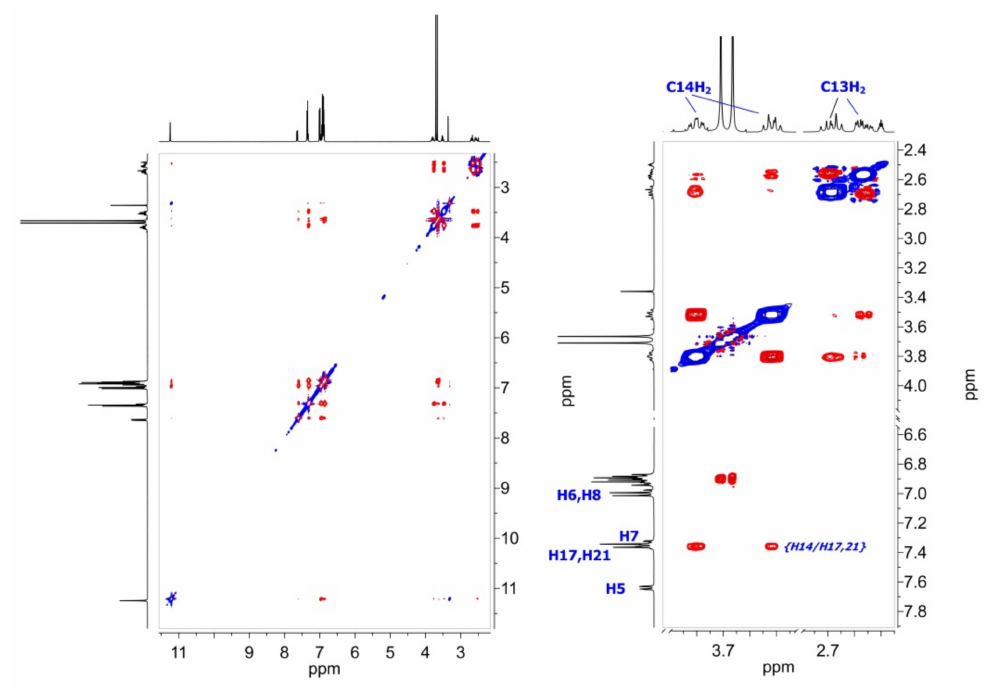
Figure 4. ROESYAD spectra of compound 5a . Atom labels correspond to the crystal structure from Figure 3.